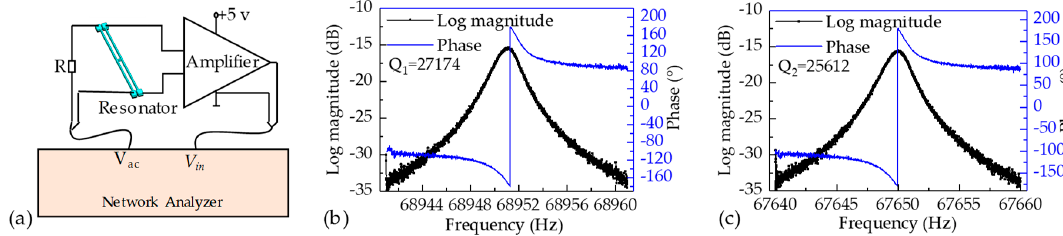
Figure 4. ( a ) Schematic of the open-loop measurements for the resonators of the proposed microsensor. The intrinsic frequencies, phase shifts, and Q-factors of resonator I ( b ) and resonator II ( c ) under an atmospheric pressure of ~100 kPa and room temperature of ~25 °C.